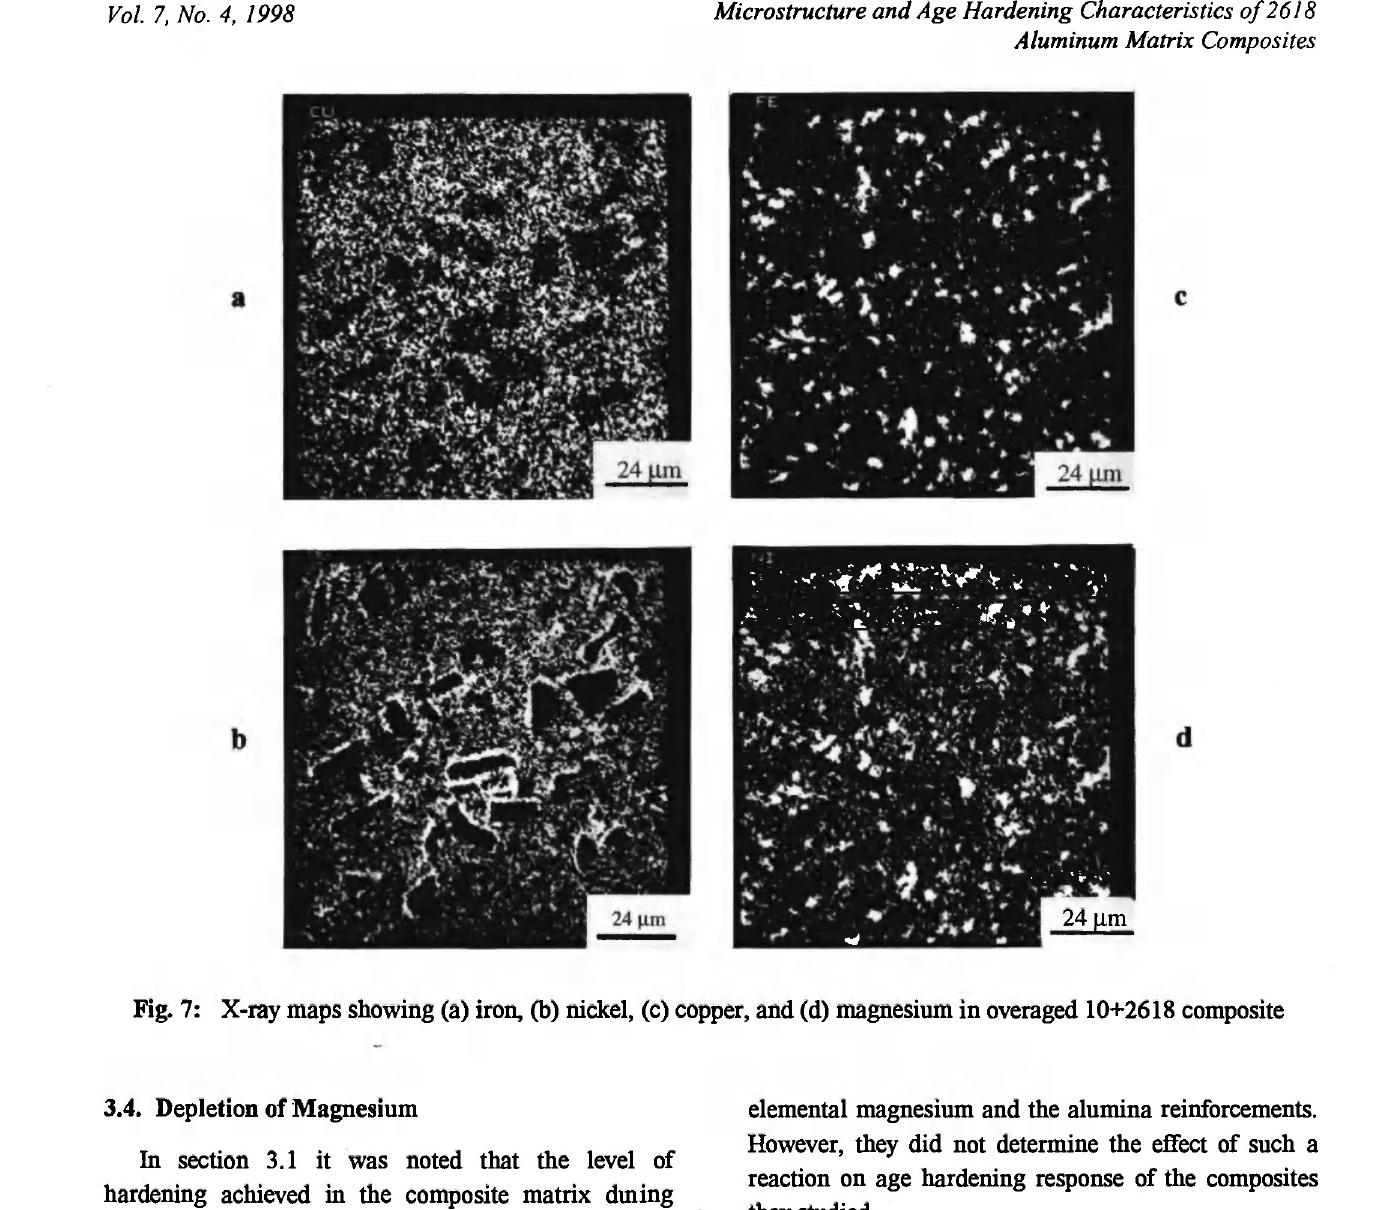
Fig. 7: X-ray maps showing (a) iron, (b) nickel, (c) copper, and (d) magnesium in overaged 10+2618